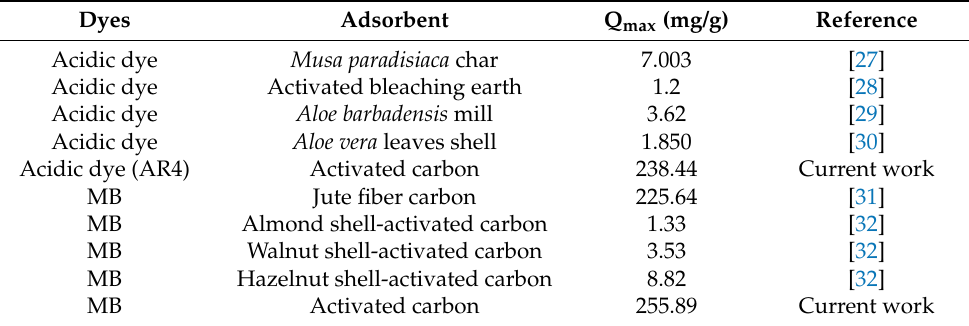
Table 7. Comparison of adsorption capacities of various adsorbents for acidic dyes, AR4 and MB with current research